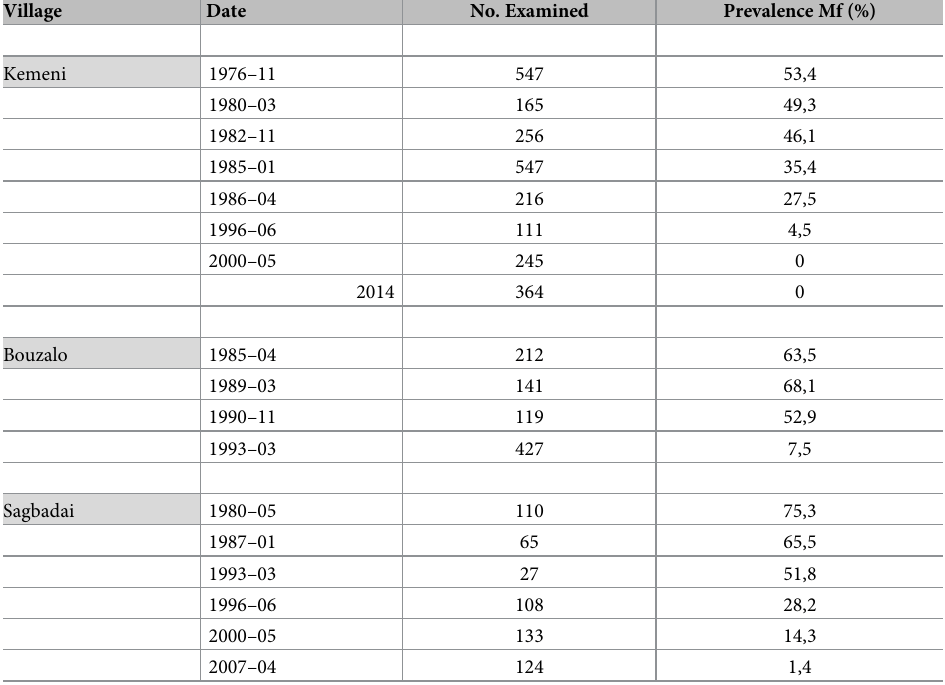
Table 5. Repeated surveys on Onchocerca volvulus infestation in villages Bouzalo, Kemeni and Sagbadai. The prevalence of O . volvulus microfilariae (mf) in skin biopsies in study populations was determined from before mass drug administration (MDA) of ivermectin and several years with the annually repeated MDA. The mass drug adminis- tration (MDA) with ivermectin began in 1988 and continued after Onchocerciasis Control Program (OCP) closure in 2002. In the post-OCP period in the Moˆ river basin special interventions continued with aerial larvicide application for five additional years (2003–2007) and MDA with ivermectin implemented twice annually. The surveyed years, number of examnied participants and the prevalence of O . volvulus mf in skin biopsies are shown. Village No.